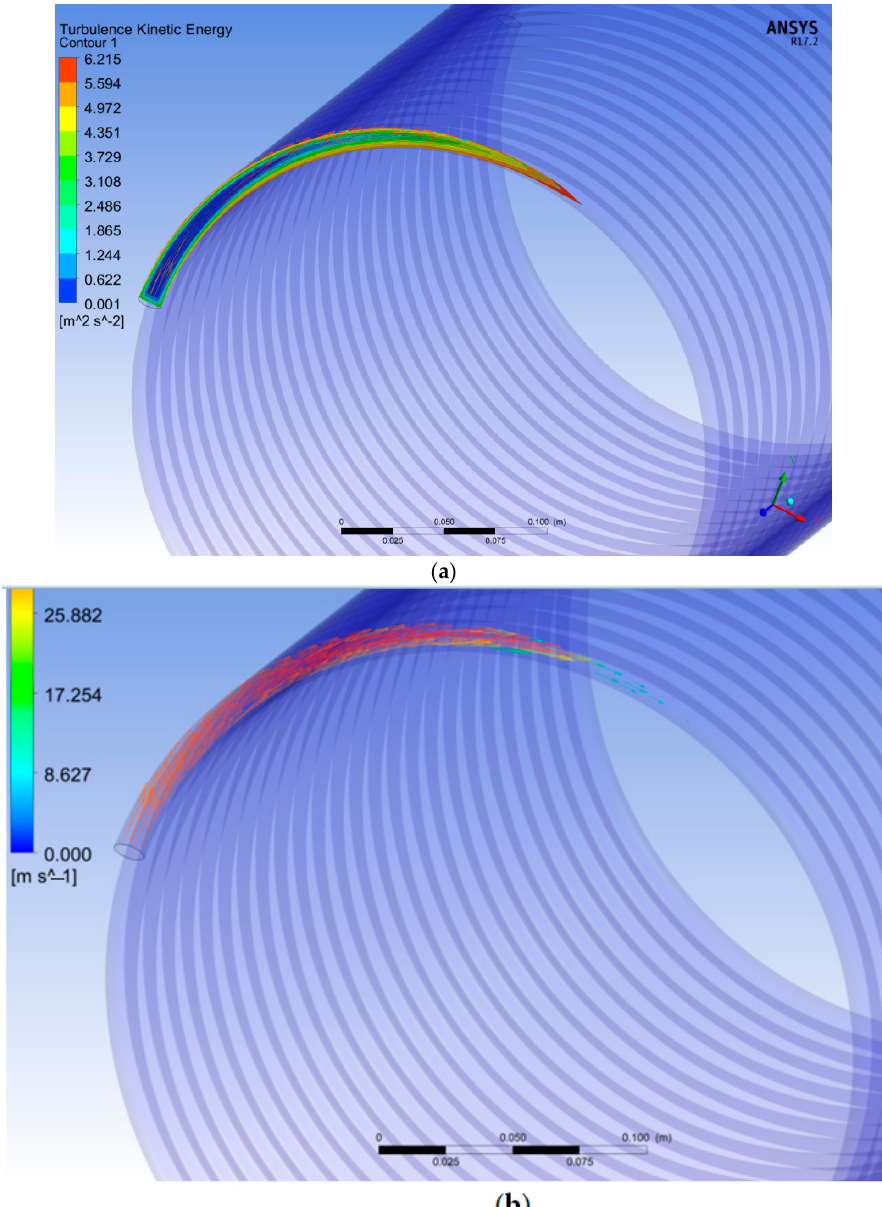
Figure 9. The results of modeling the hydraulic process in a coil for a laboratory stand: ( a ) kinetic energy and ( b ) velocity vectors of the